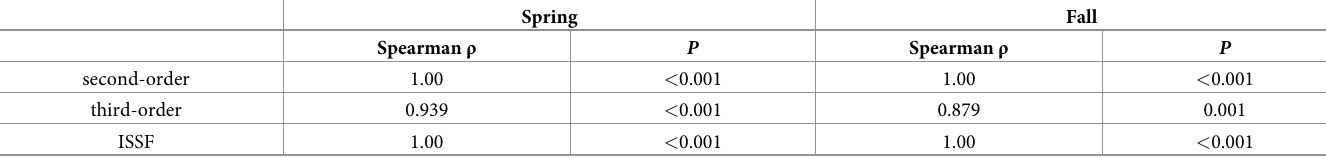
Table 2. Spearman rank-based model validation results for second-order, third-order, and scale-integrated step selection function (ISSF) models of female prong- horn migrations across the Northern Sagebrush Steppe, 2004–2010.